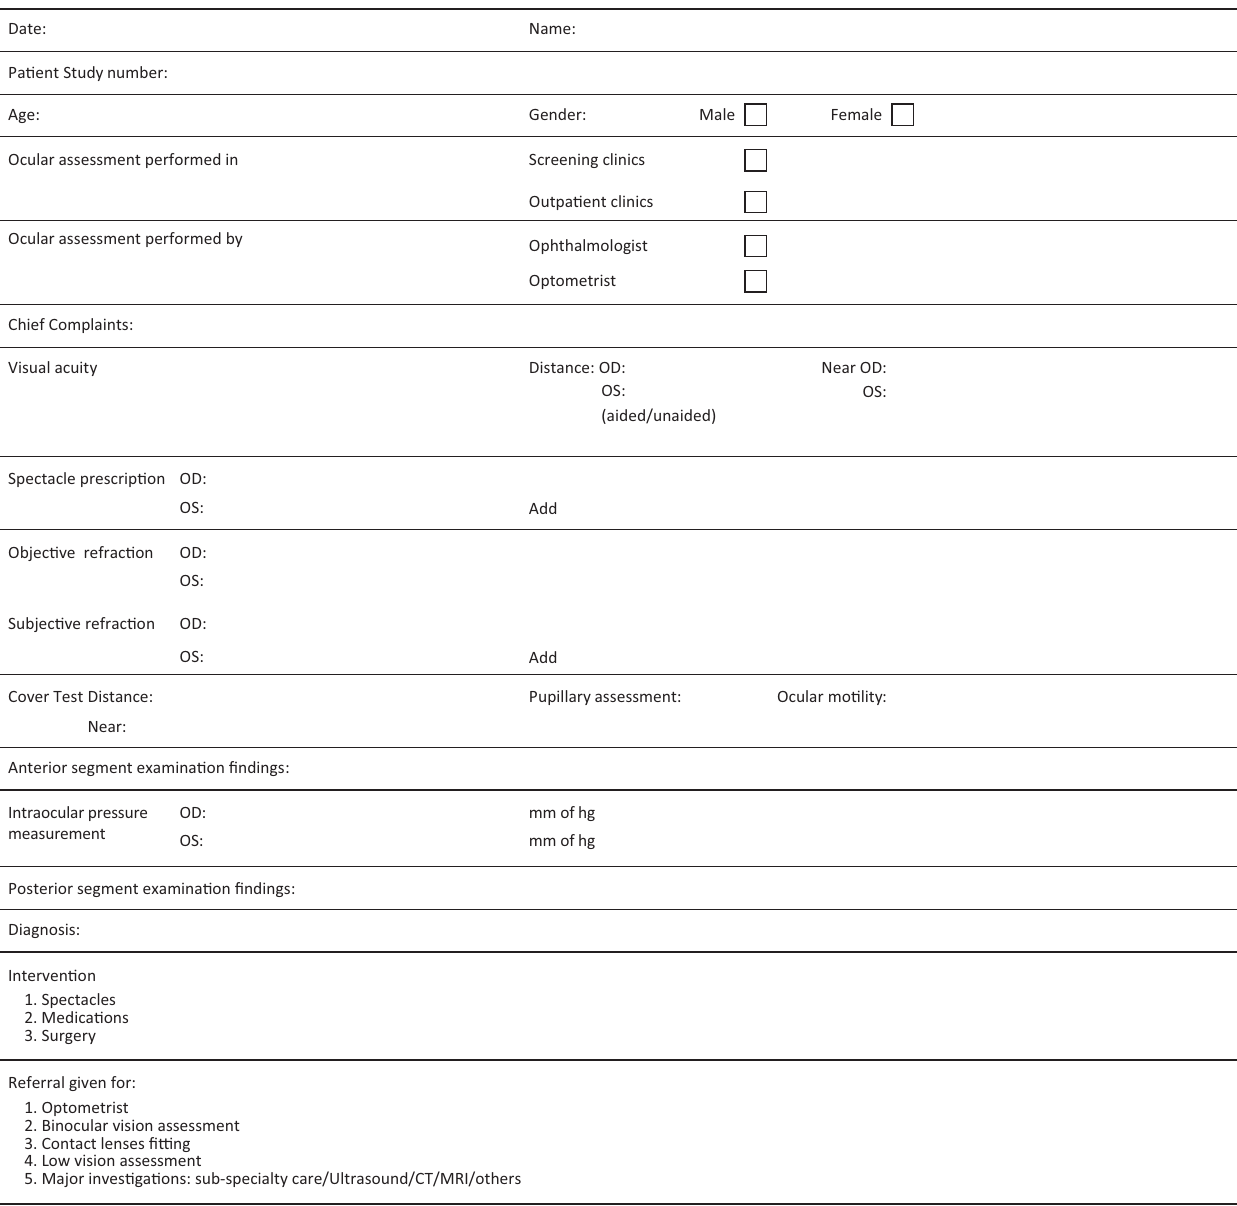
FIGURE 1-A1: Data collection